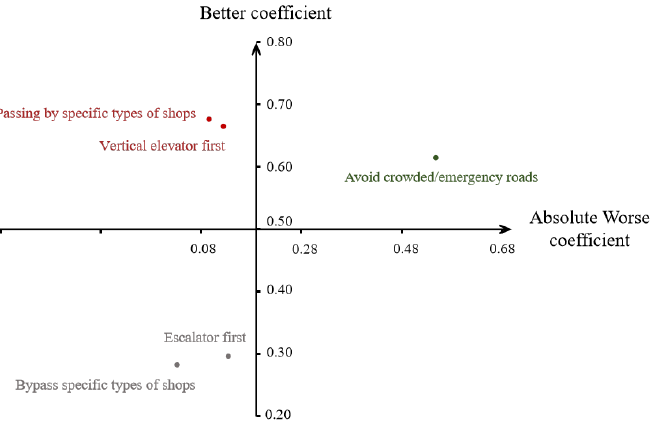
Figure 17. Better – Worse coefficient quadrant diagram.